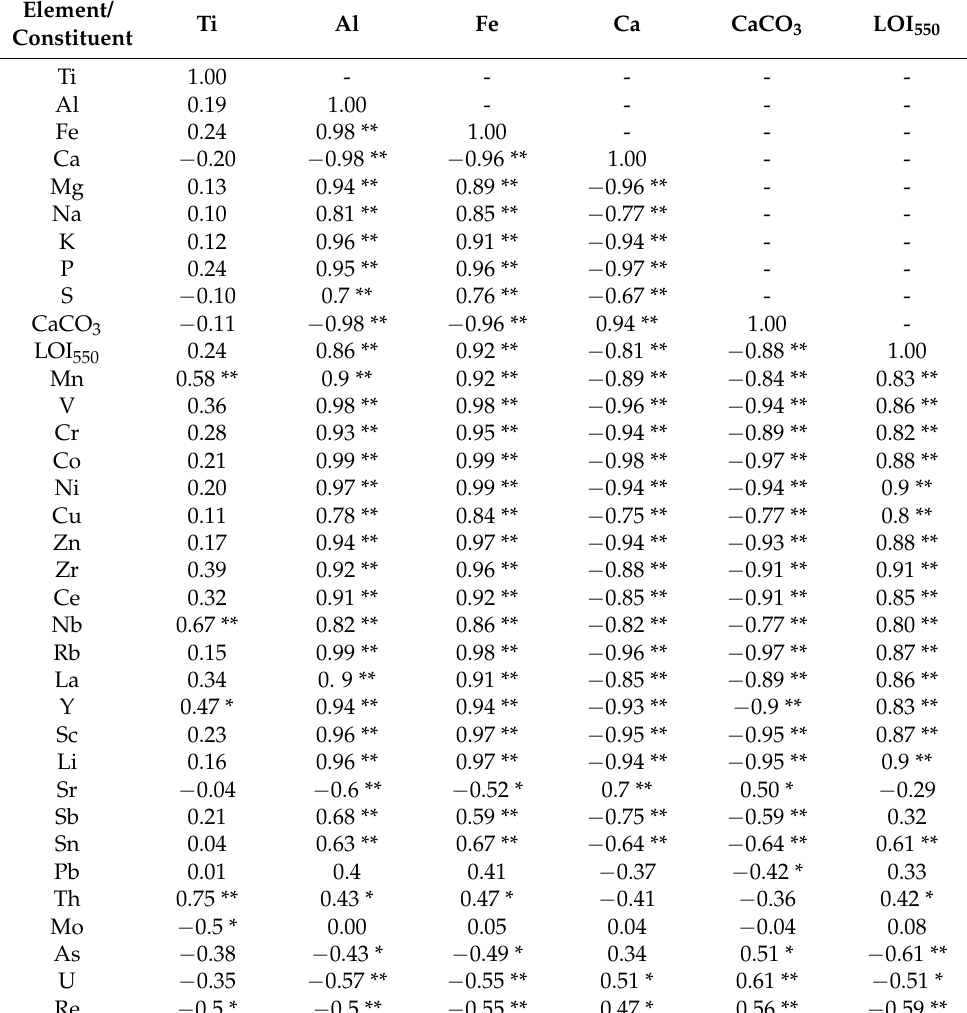
Table 2. Pearson correlation matrix between Ti, Al, Fe, Ca, CaCO 3 , and LOI 550 and major, minor, and trace elements in the shallow subsurface coastal sediments of the creek that was connected with the two Al-Shuaiba